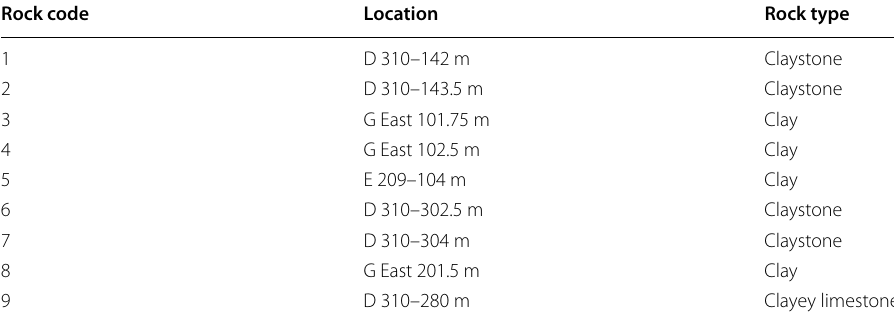
Table 1 Sampling locations and rock